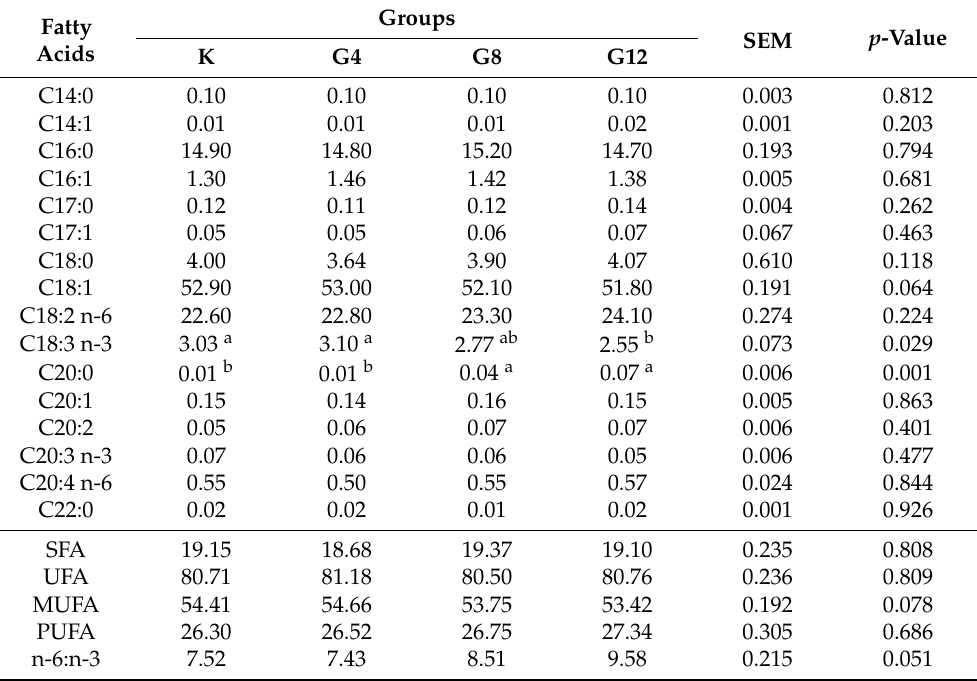
Table 8. Fatty acids profile (% of total fatty acids) in breast muscles of broiler chickens fed graded levels of guar